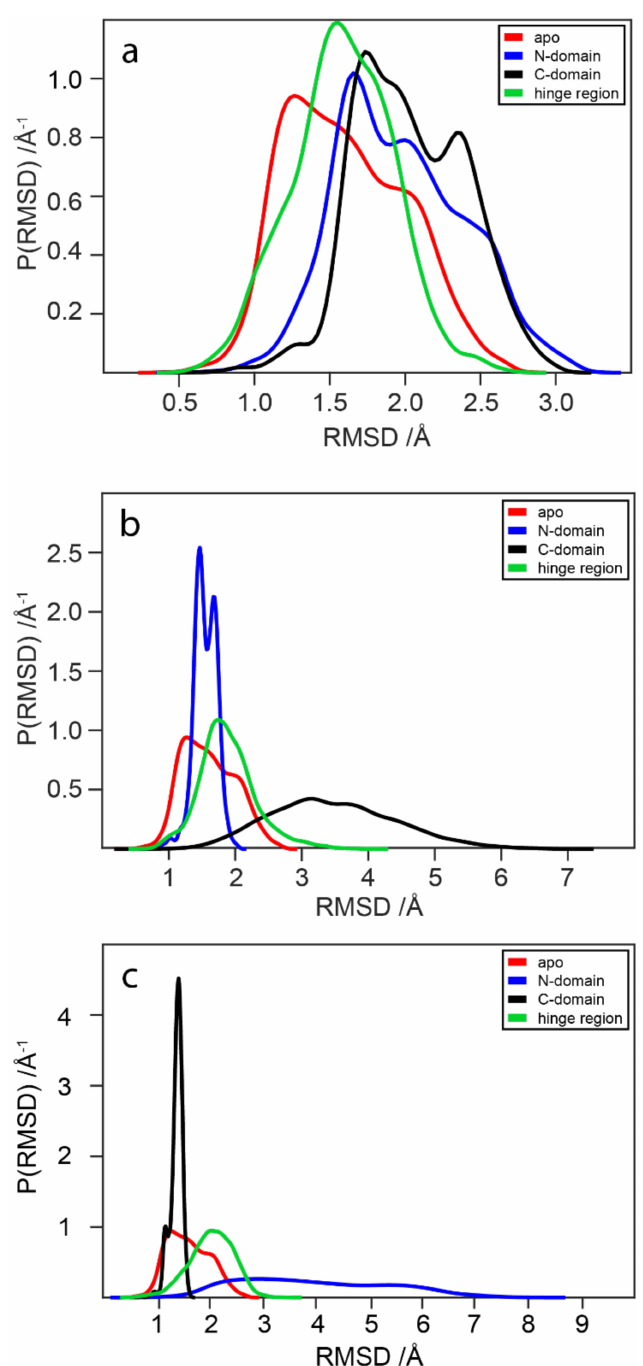
Figure 10. RMSD probability distributions obtained by a kernel density estimate using a normal distribution function. The calculation is done on the protein backbone of the apo -protein (from 2iw1, red) as a reference of RMSD values. Alignment of ( a ) the entire protein backbone, ( b ) N-domain, and ( c ) C-domain of apo , then RMSD calculation of the N- and C-domain and hinge